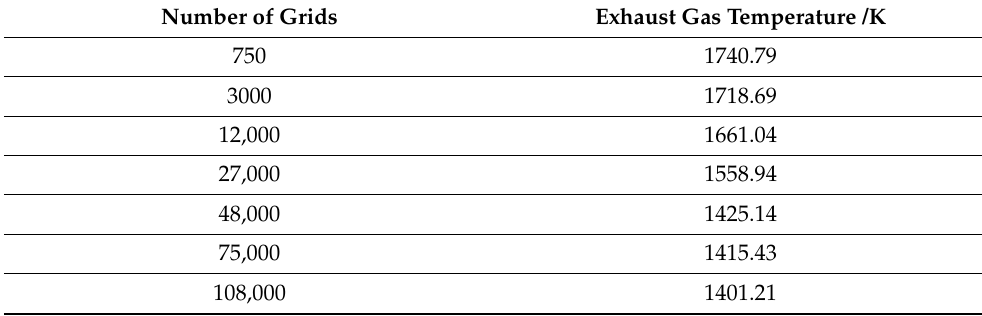
Table 1. Grid number assessment parameter table.